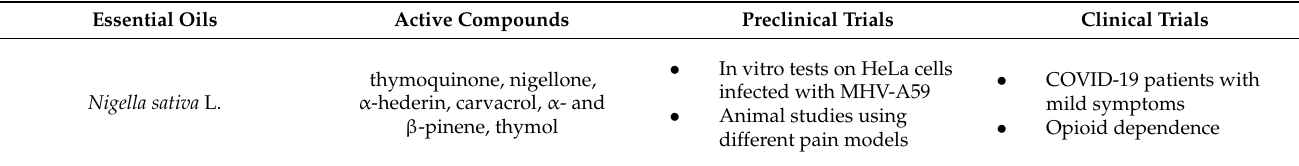
Table 1. Essential oil tested in preclinical and clinical